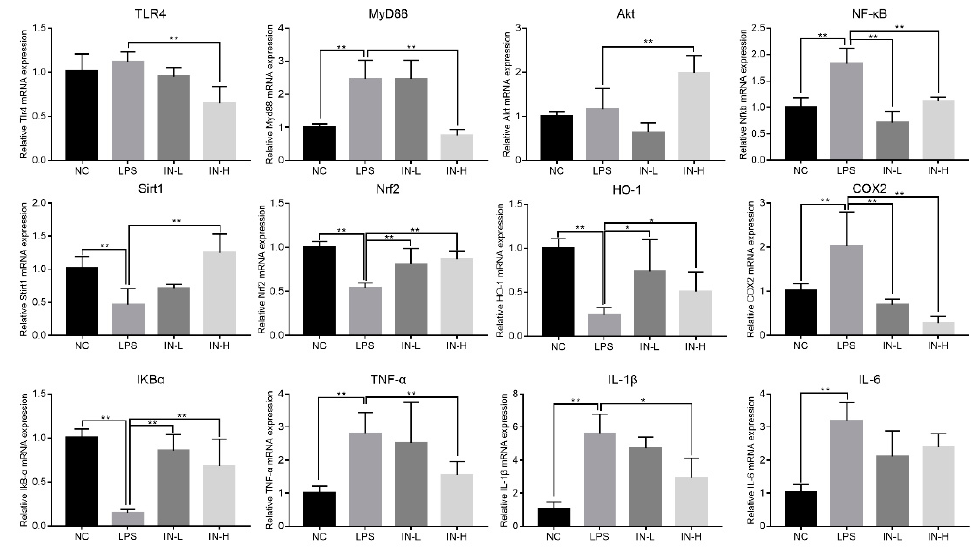
Figure 7. Impact of inosine pre-intervention on the transcription of genes related to the TLR4/MyD88/NF- κ B signaling pathway in mice treated with LPS. * p < 0.05; ** p < 0.01, relative to the LPS group,.